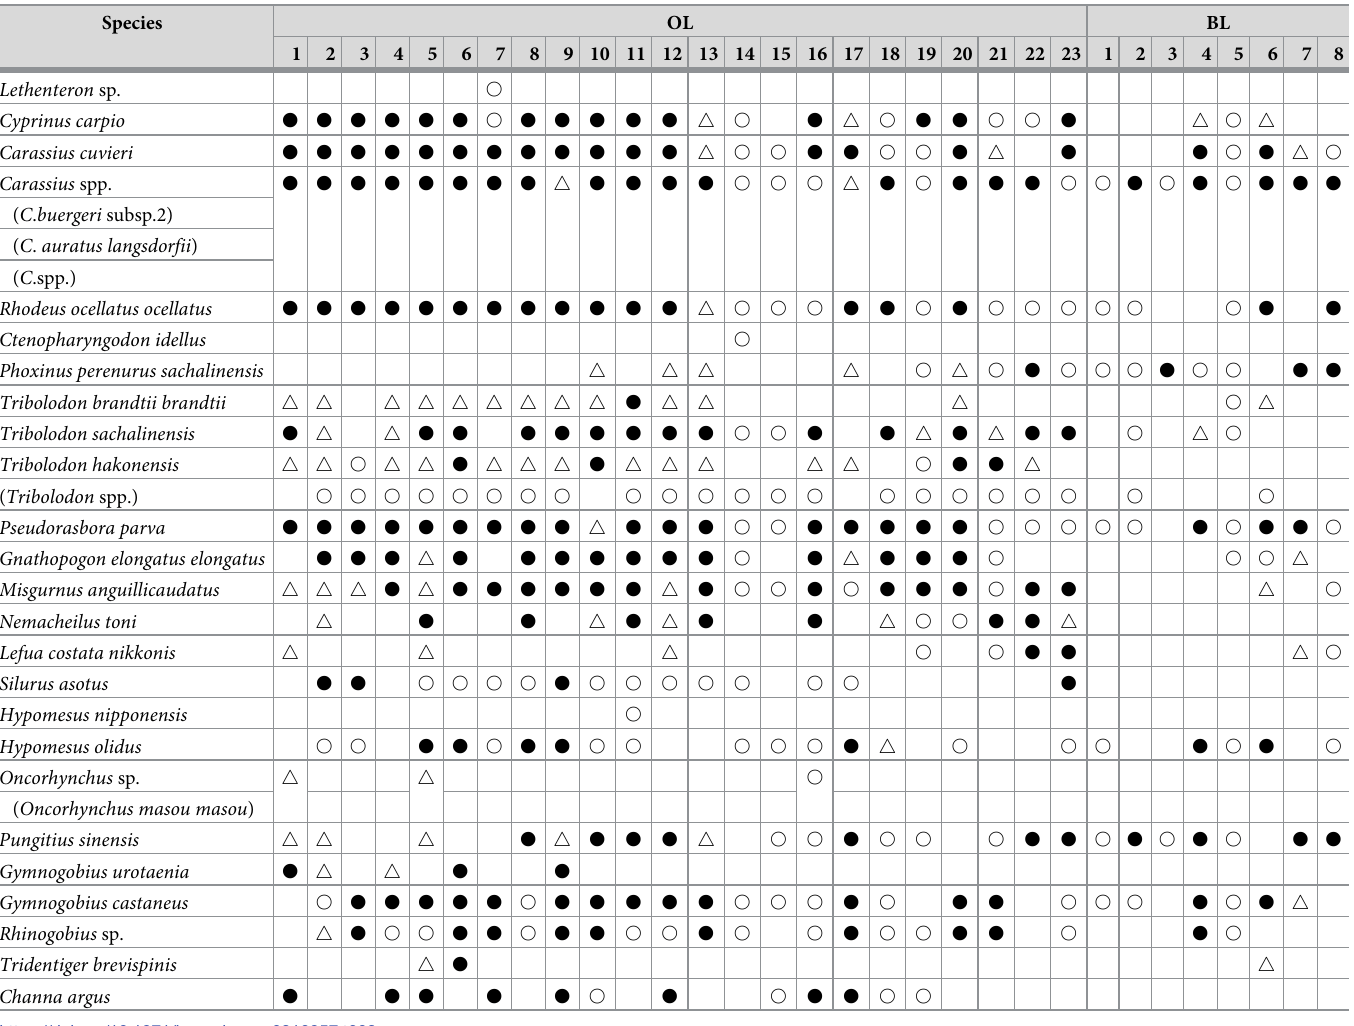
Comparing the ordination of fish communities between traditional capture and eDNA metabarcoding data